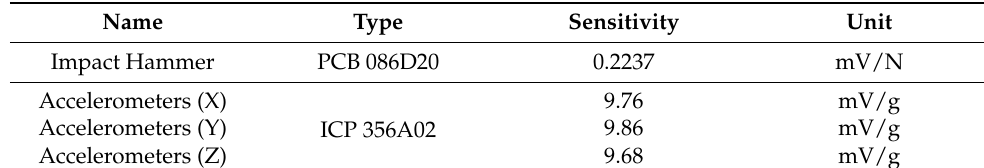
Figure 9. Vertical machining center: ( a ) experimental model; ( b ) EMA model.